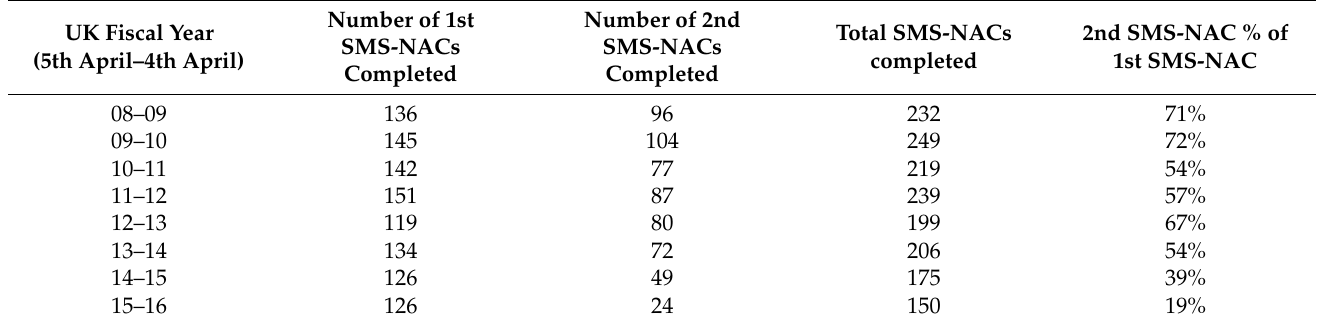
Table 1. 2008 annual report data showing repeated administration of the SMS-NAC and the percent- age proportion of second SMS-NACs completed by first